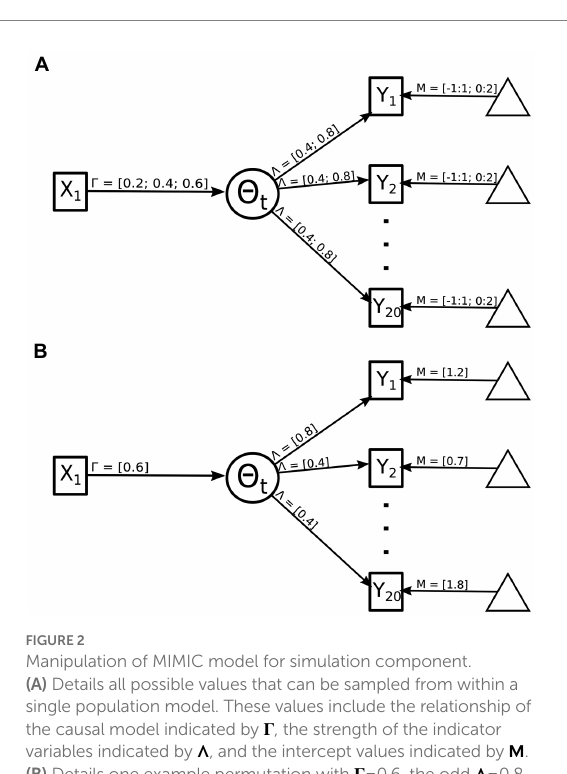
FIGURE 2 Manipulation of MIMIC model for simulation component. (A) Details all possible values that can be sampled from within a single population model. These values include the relationship of the causal model indicated by 𝚪 , the strength of the indicator variables indicated by 𝝠 , and the intercept values indicated by 𝝡 . (B) Details one example permutation with 𝚪 = 0.6, the odd 𝝠 = 0.8, the even 𝝠 = 0.4, and the 𝝡 is selected between 0:2 with a uniform